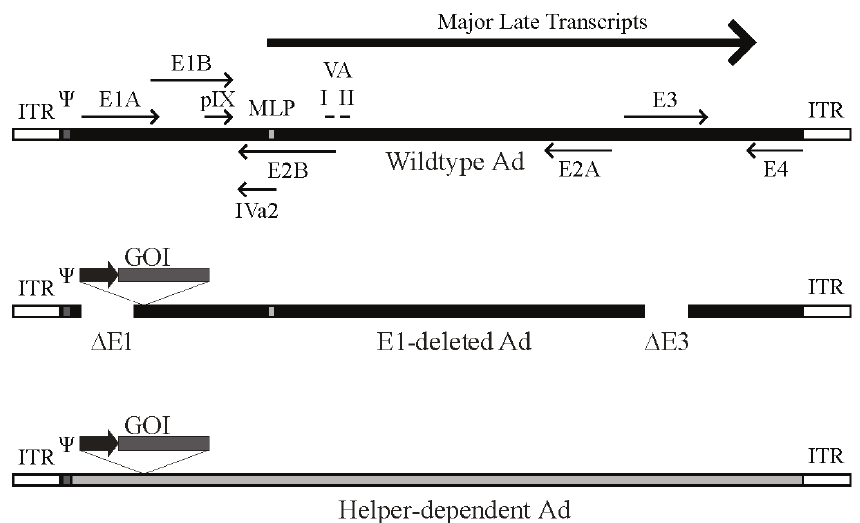
Figure 1. Schematic of the adenovirus genome and adenovirus-based vectors. Top panel: A simplified map of the adenovirus (Ad) serotype 5 genome showing the early genes (E1–E4) and the region from which the major late transcript is produced (the L1-L5 transcripts produced from alternative splicing of the major late transcript are not